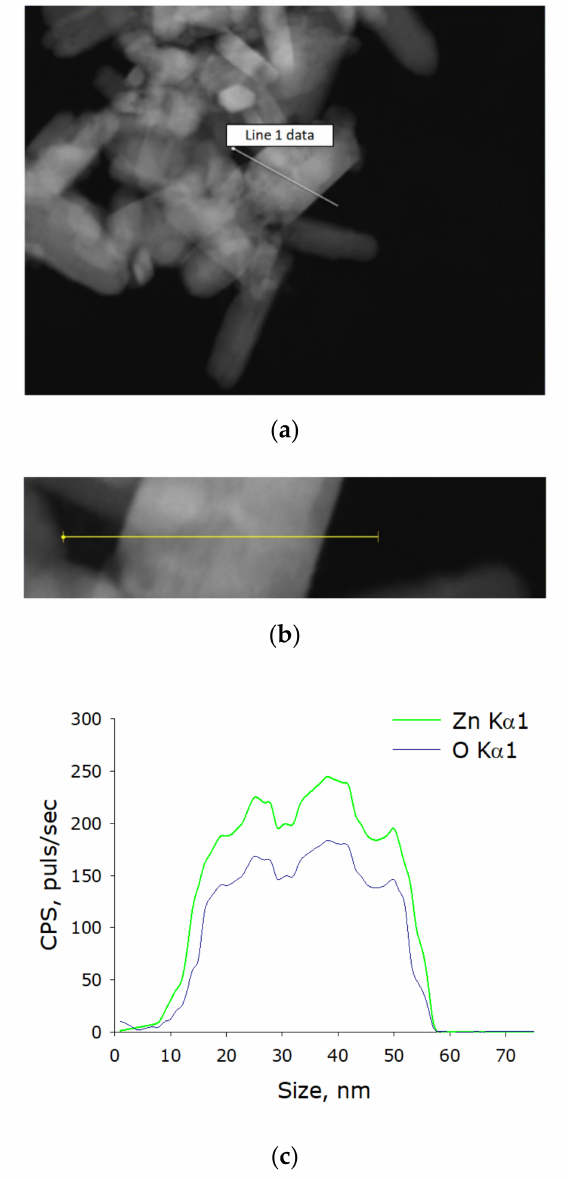
Figure 2. Elemental analysis of zinc oxide NPs. ( a ) TEM image of group of zinc oxide NPs, analysis section is indicated by line 1. ( b ) Enlarged measurement site. ( c ) Nanoparticle profile by Zn K α 1 and O K α